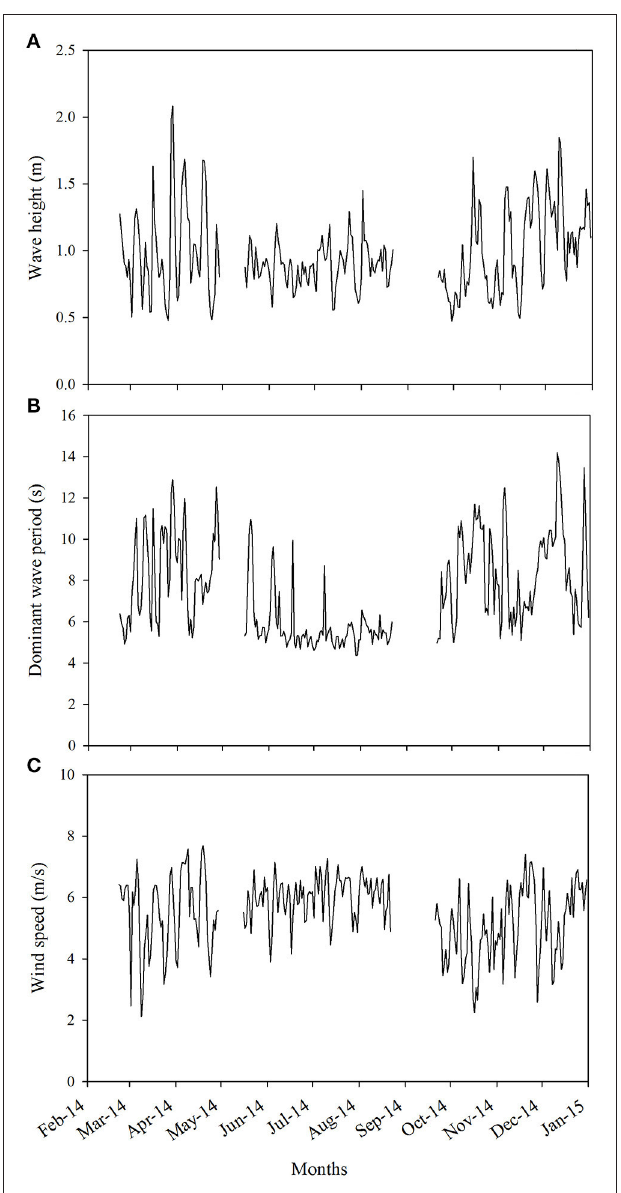
FIGURE 6 | Variations of meteorological and oceanographic environmental data through the study period. Wind speed (A) , dominant wave period (B) , and wind speed (C) . Data acquired from CARICOOS NDBC 41056 buoy.